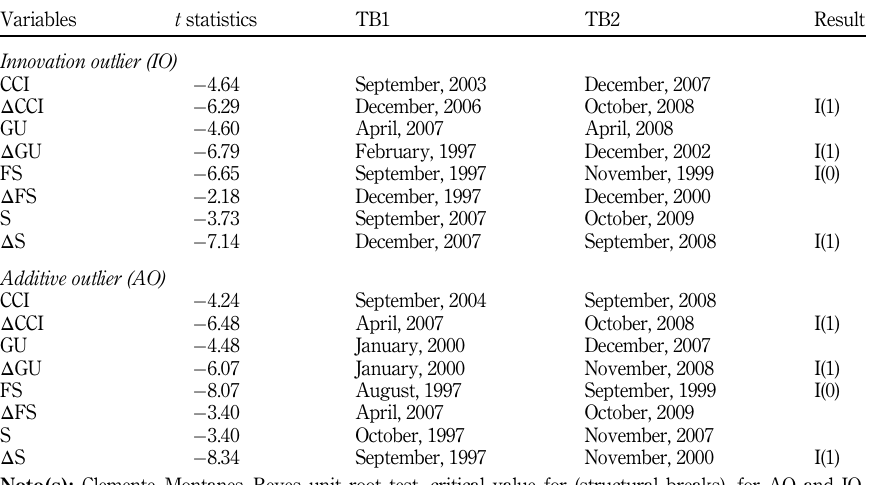
Table 4. Clemente – Montanes